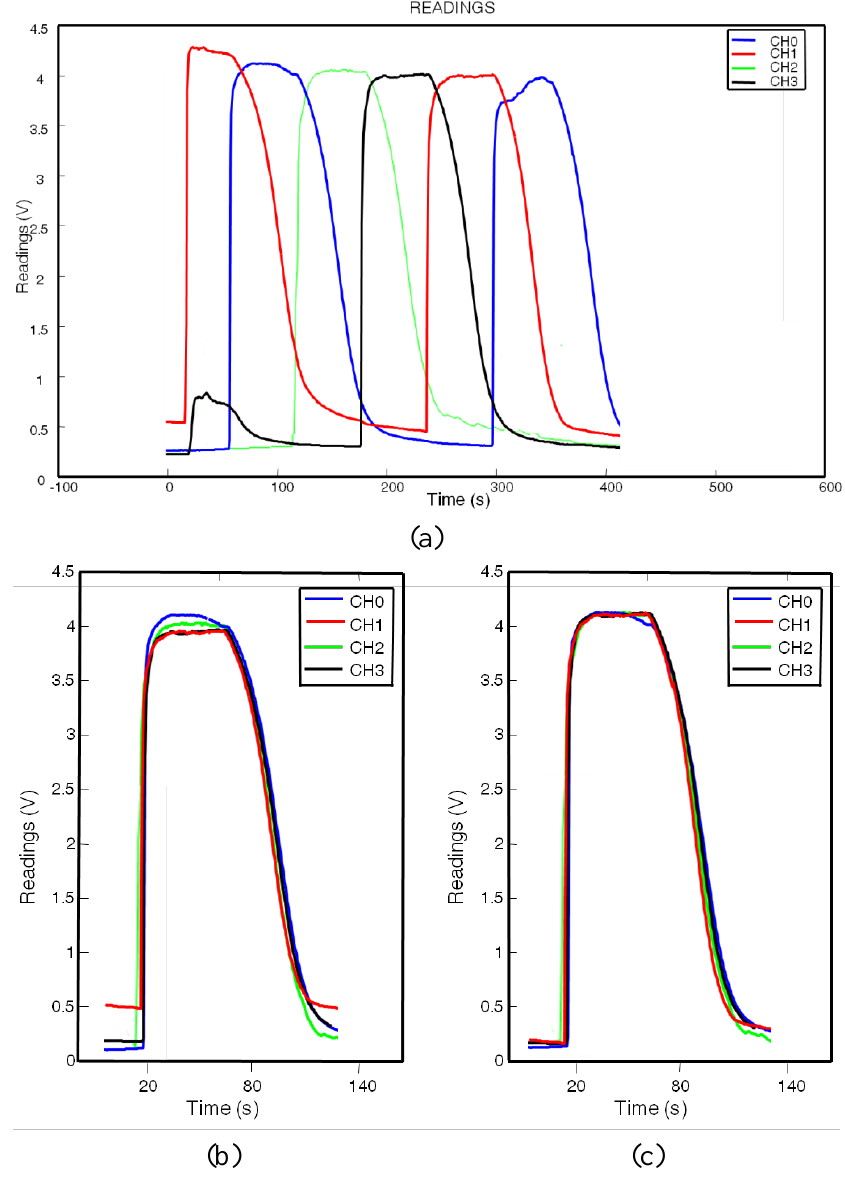
Figure 9. (a) Readings of four TGS-2602 sensors placed in each chamber of the MCE-nose prototype during the calibration procedure. (b) Comparison of the four sensor readings before calibration, and (c) after